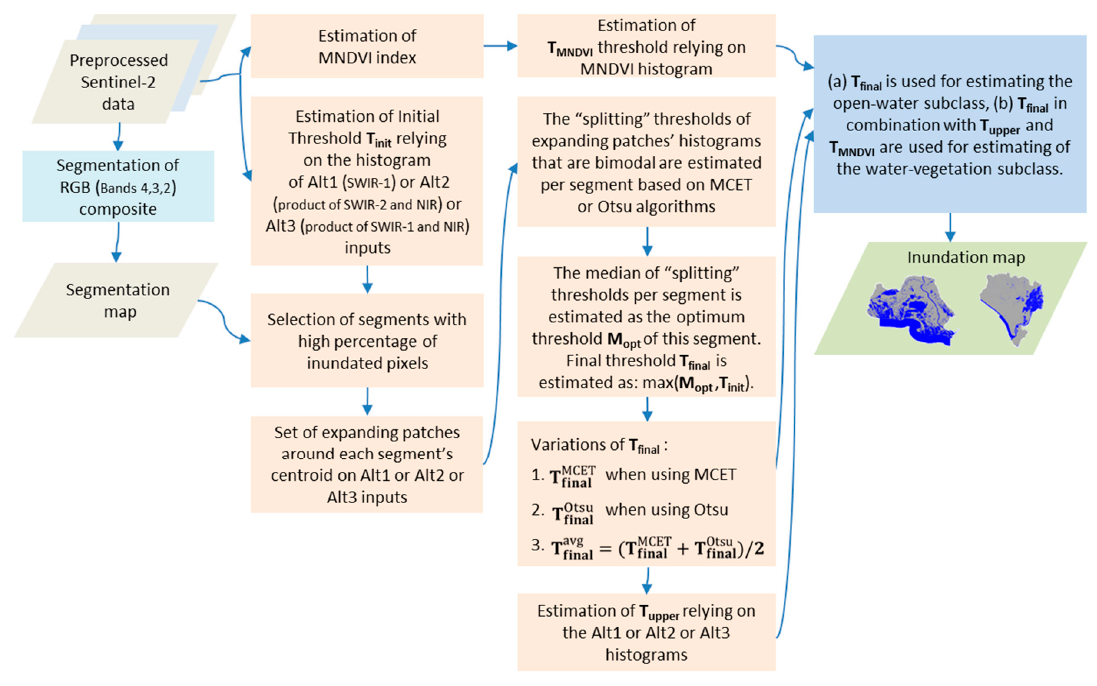
Figure 3. Schematic flow diagram of the automatic thresholding methodology.